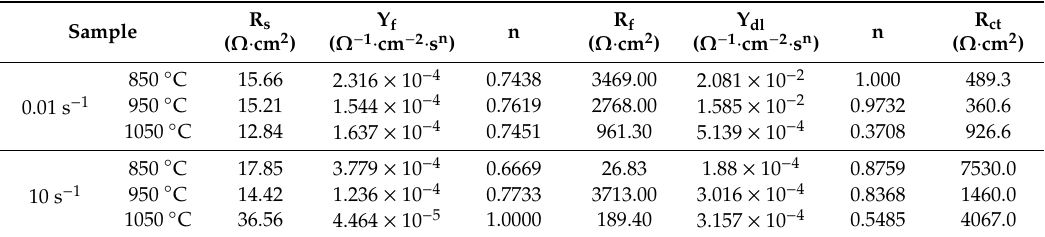
Table 3. Spectra fitting results of experimental 35CrMoV steel in 3.5 wt% NaCl